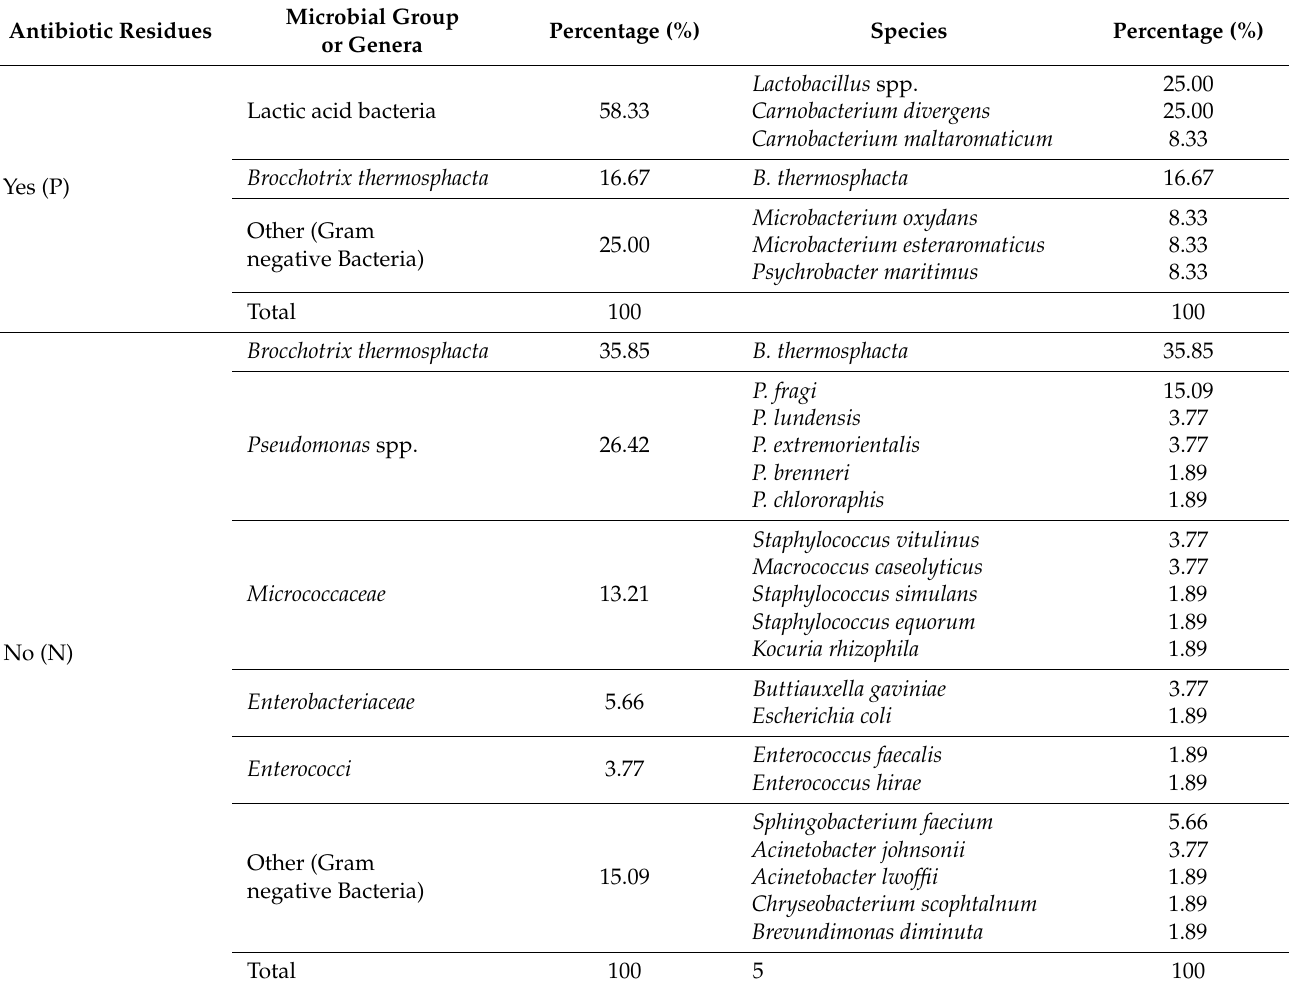
Table 1. Bacteria identified in fresh goat meat from Plate Count Agar. Samples with the presence of antibiotic residues (P) and free of antibiotic residues